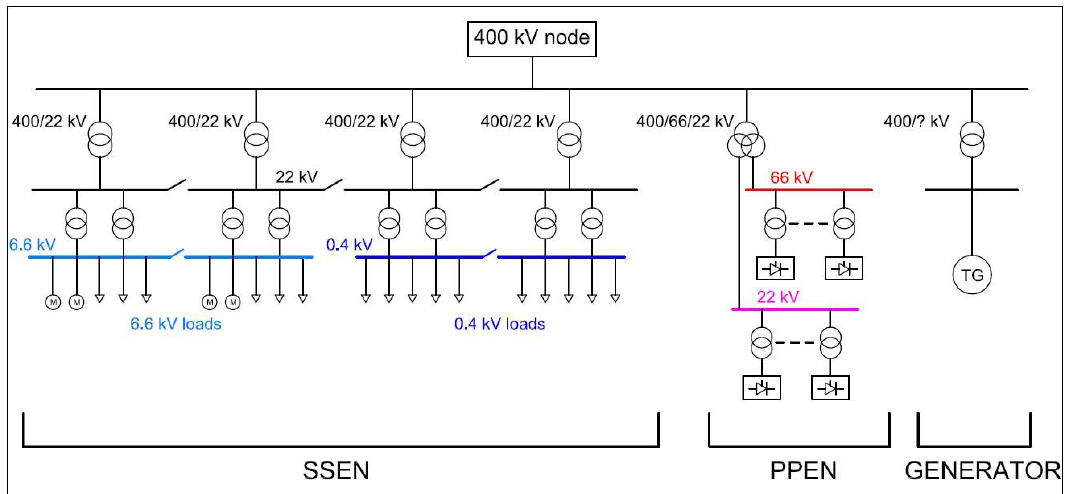
Figure 4. Preliminary sketch of a possible DEMO electrical power system configuration, emphasizing the division of the electrical distribution into three groups: SSEN, PPEN and TG.